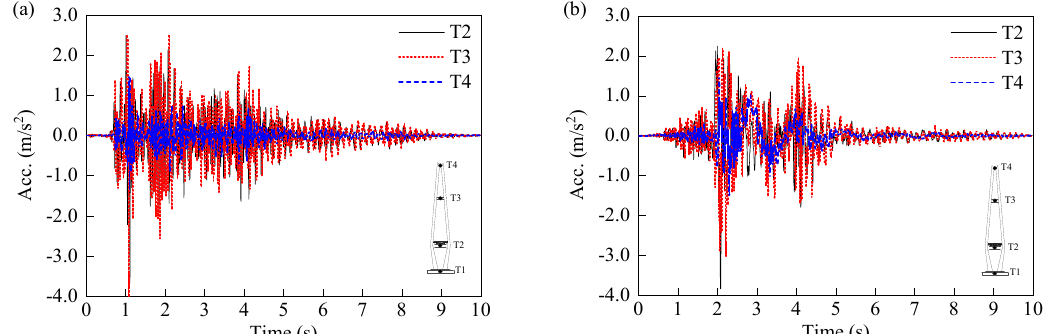
Figure 12. Accelerations time history of 3# tower ( a ) subjected to ScEL; ( b ) subjected to ScTCU.